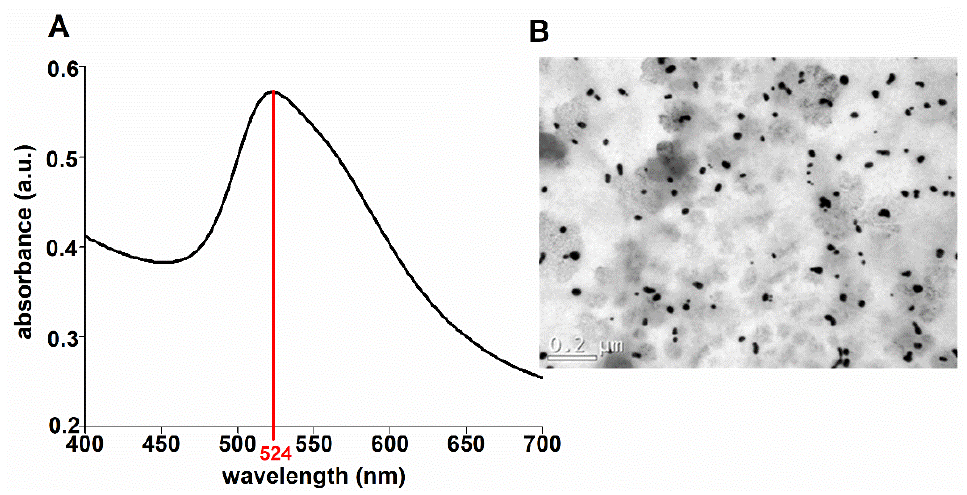
Figure 1. UV – VIS spectroscopy ( A ) and TEM images ( B ) of the GNP solution were obtained.